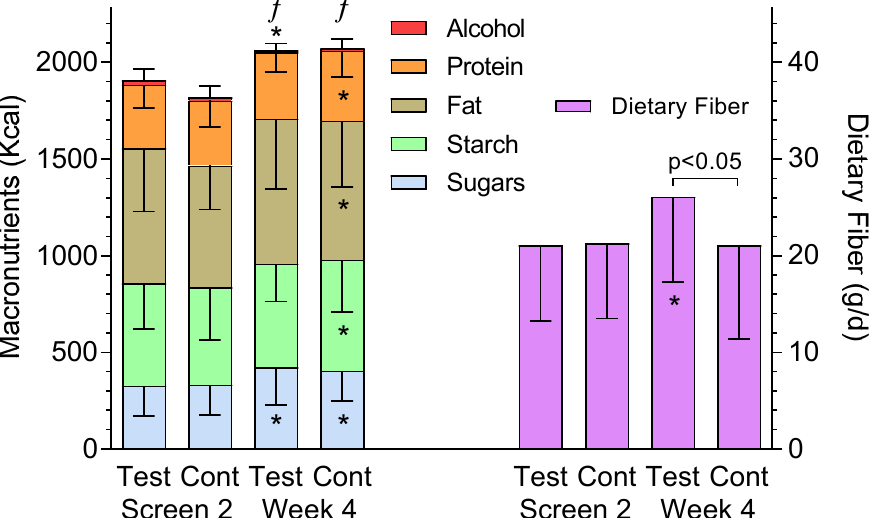
Figure 1. Macronutrient and dietary fiber intakes during the trial. Bars represent mean ± SEM intakes (expressed in Kcal for sugars, starch, fat, protein and alcohol) and grams for dietary fiber before treatment (dietary records obtained at the second screening visit; Screen 2) and during treatment (Week 4) for n = 96 on Test and n = 95 on Control (Cont). Error bars go down for sugars, starch, fat, protein and dietary fiber and up for alcohol. The only significant difference between Test and Control is for fiber. * Asterisks below the error bars indicate a significant difference from Screen 2 for the respective nutrient, except for alcohol the asterisk is above the error bar, ( p < 0.05) by paired t -test. ƒ Significant difference in energy intake between Screen 2 and Week 4 ( p < 0.05) by paired t-test.